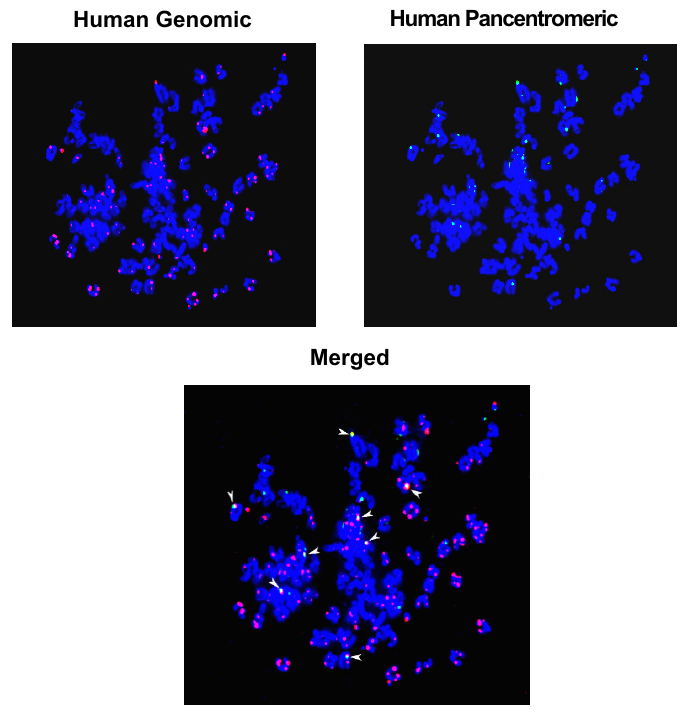
Figure 9. FISH detection of genomic integration of human DNA in mouse cells highlighting co-localization of human genomic and human pan-centromeric signals (arrow heads). Metaphase spreads were prepared from a single cell clone developed from NIH3T3 mouse fibroblast cells treated with cfCh isolated from sera of cancer patients [64]. FISH was performed using human whole genomic and human pan-centromeric probes as described in reference [64]. Magnification x60. (Unpublished data form authors’ lab).